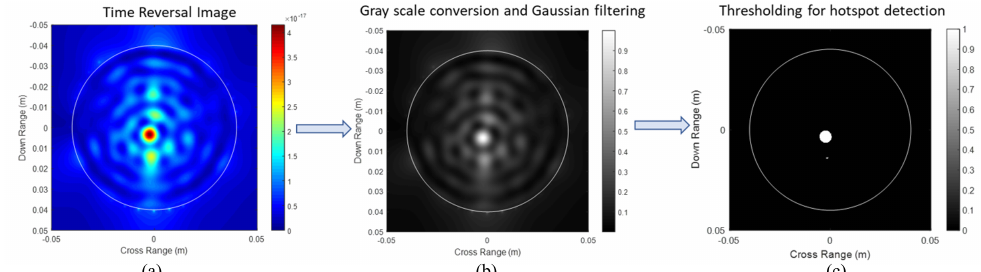
Figure 7. Image processing steps for the detection of targets. Root size and shape estimation of the large carrot ( a ) time reversal image, ( b ) image after gray scale conversion and Gaussian filtering and ( c ) thresholding for hotspot